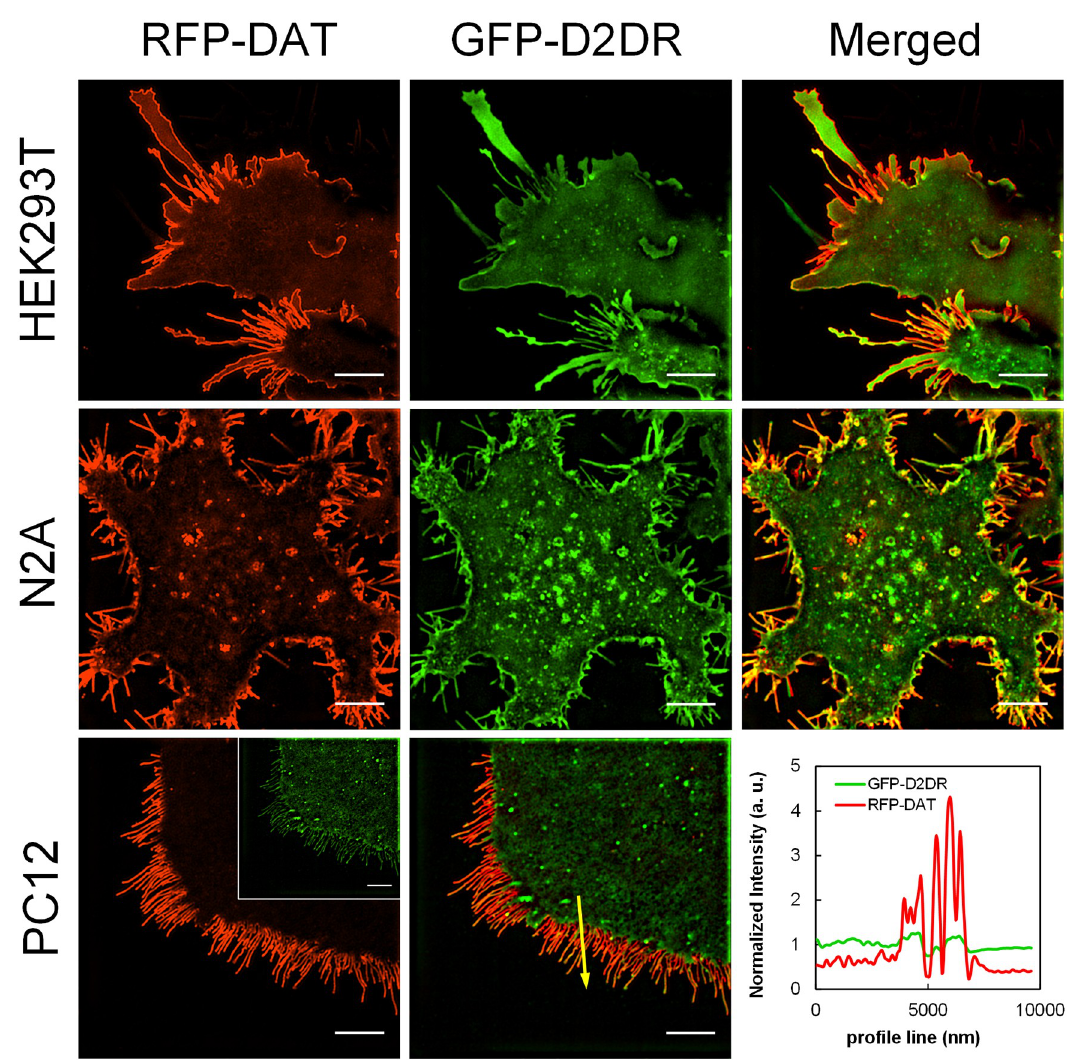
Fig 5. Differential membrane localization of RFP-DAT/GFP-D2DR in various cell hosts revealed via SIM superresolution microscopy. Bottom left: an image of the distribution of RFP-DAT expressed in a PC12 cell; inset is an image of the distribution of GFP-D2DR in the same cell. Bottom center: an image of RFP-DAT/GFP-D2DR colocalization in the PC12 cell shown in bottom left. Bottom right: the plot represents an intensity profile of the yellow line drawn across a segment of a membrane of a PC12 cells coexpressing RFP-DAT and GFP-D2DR. Scale bar: 5 μ m. Images are representative of at three independent experiments. Two MatTek dishes plated per passage with three to six 512x512 fields of view acquired per MatTek dish constituted an independent